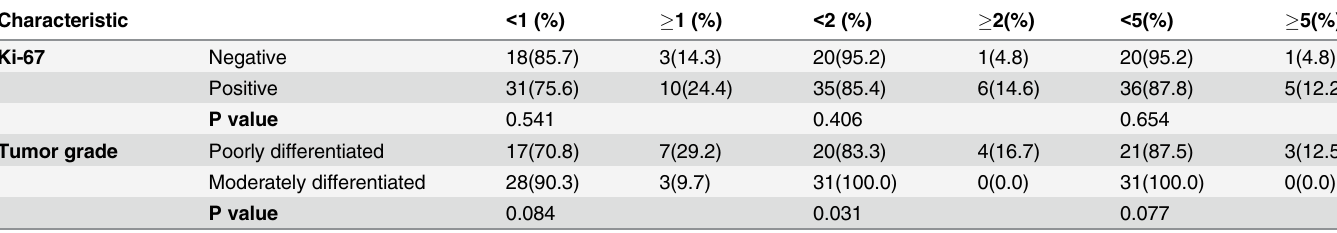
Table 4. Association between CTC count and Ki-67 and tumor grade data.